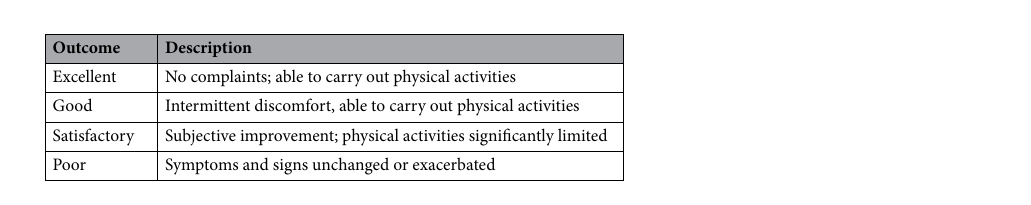
Table 3. Odom’s criteria 25 .